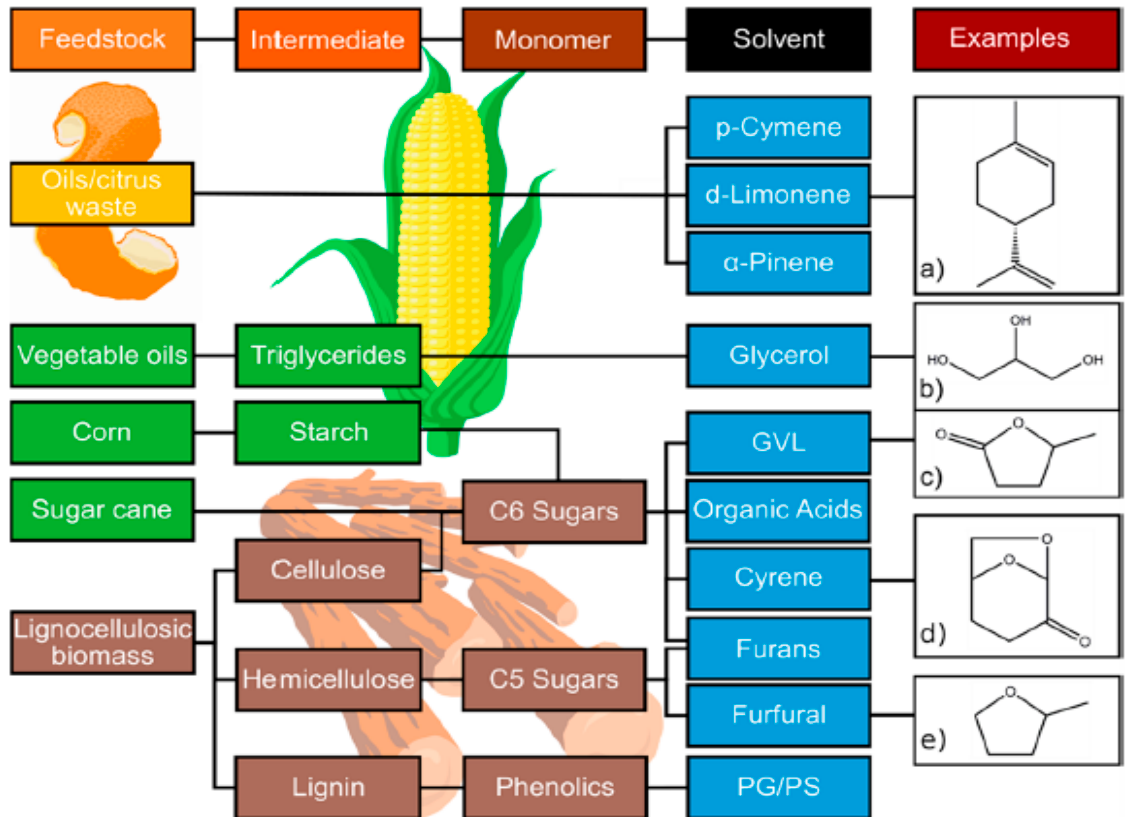
Figure 8. A number of sustainable solvents can be derived from plant biomass. While plant sugars and oils require less processing, lignocellulosic biomass can produce a broader range of solvents. Structural examples show ( a ) d-limonene, ( b ) glycerol, ( c ) γ -valerolactone, ( d ) cyrene, and ( e ) 2-MeTHF. Reproduced with permission from [2].